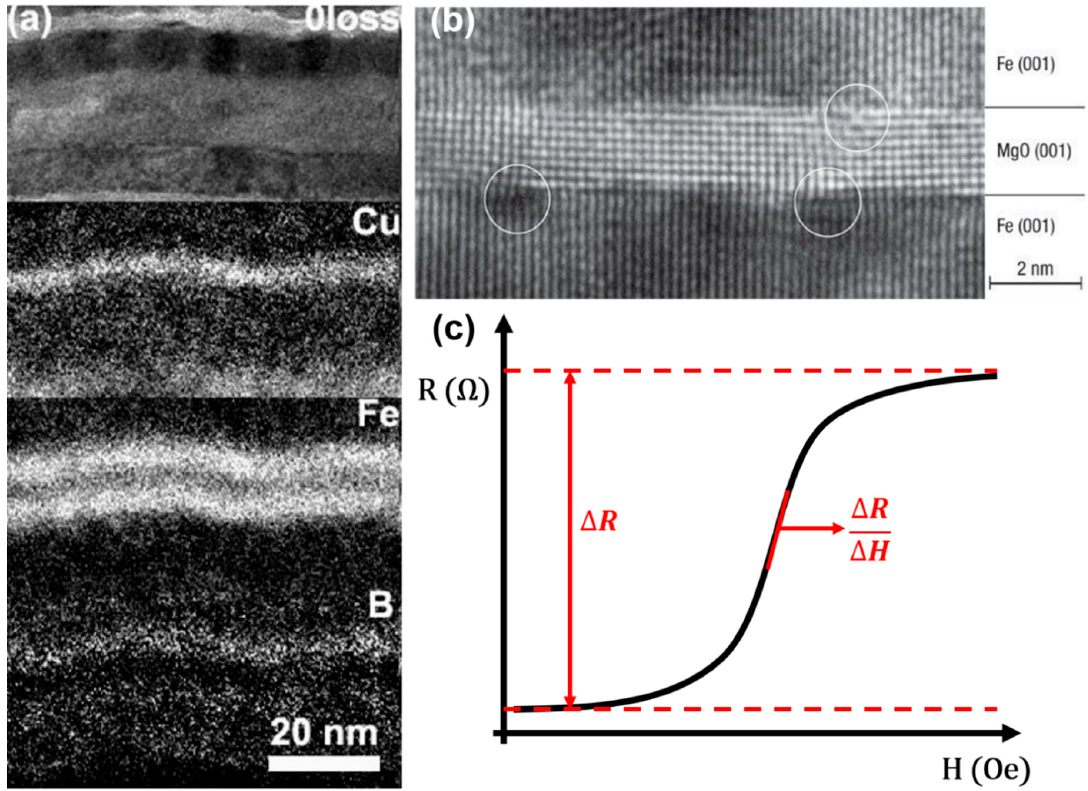
Figure 2. ( a ) Energy filtered TEM image of a giant magnetoresistance (GMR) structure of oFe (1.5 nm) / Cu (50 nm) / IrMn (10 nm) / CoFeB (6 nm) / Cu (2.5 nm) / CoFeB (6 nm) / Ru (8 nm) [51]; ( b ) MgO-based magnetic tunnel junction (MTJ) with 180% tunneling magnetoresistance (TMR) ratio reported by Yuasa et al. [52]; ( c ) a typical transfer curve of the magnetoresistive sensors. Reprinted with permission from AIP Publishing 2010 ( a ) and Springer Nature 2004 ( b ).